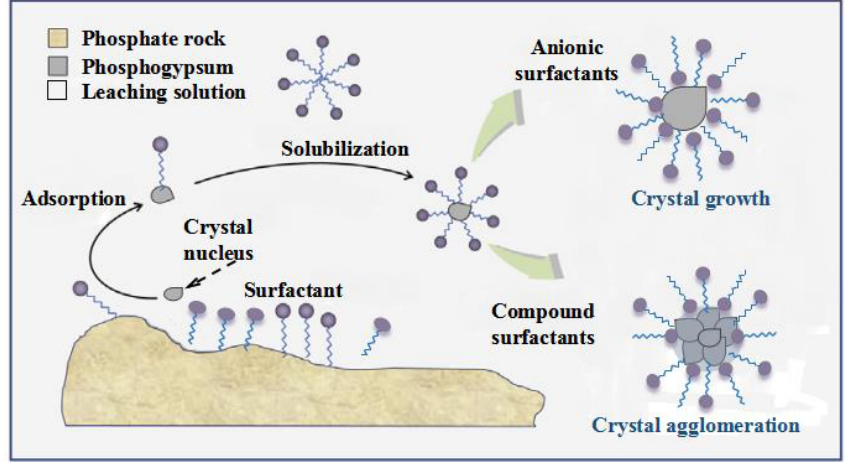
Figure 2. Process of surface-active agent in the leaching system of phosphate Figure 2. process of surface-active agent in the leaching system of phosphate rock.